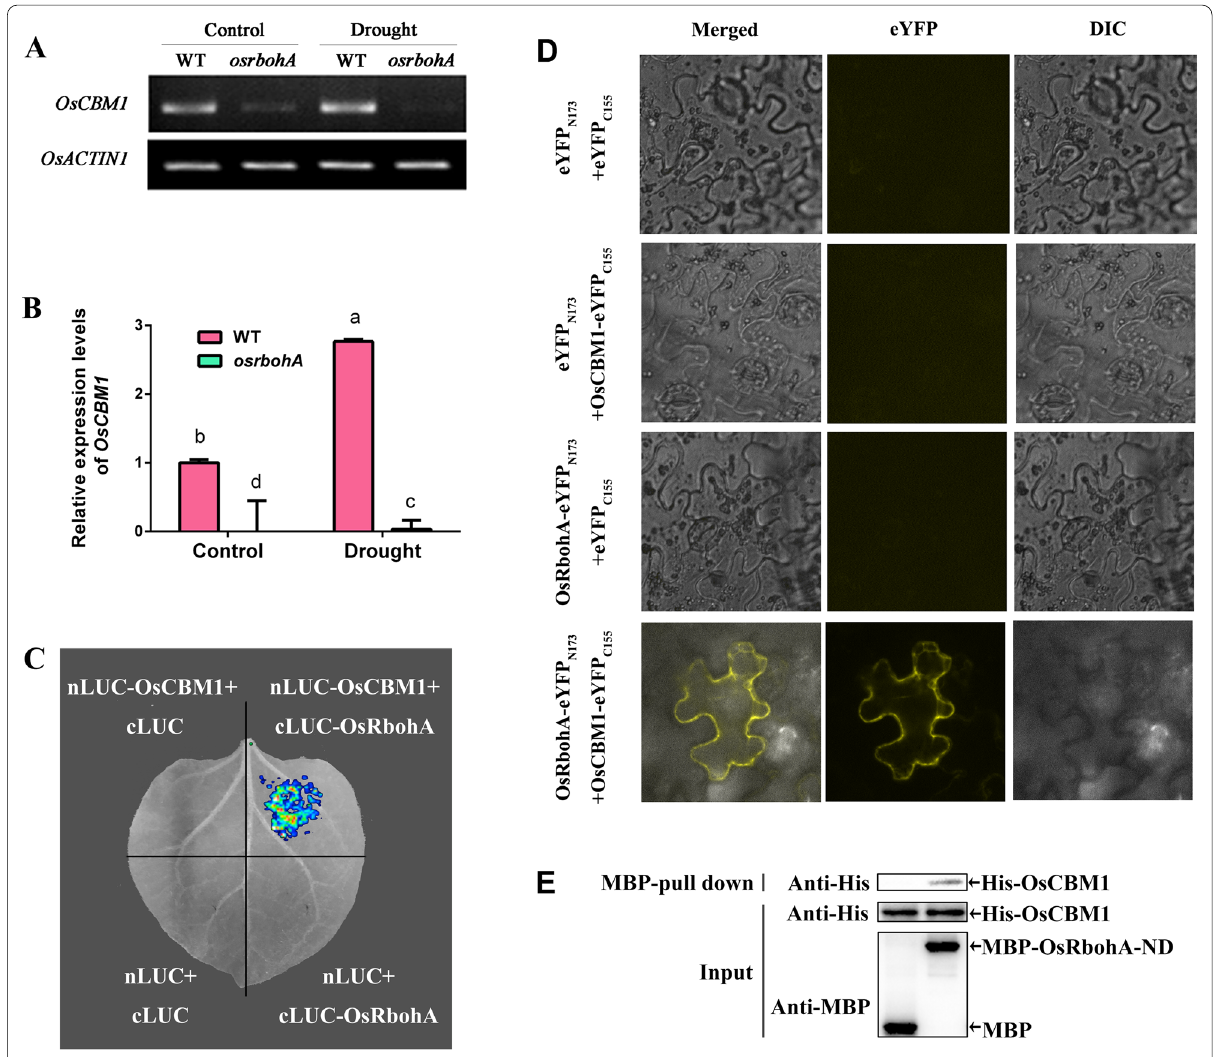
Fig. 4 OsCBM1 interacts with OsRbohA and showed very high coexpressions with OsRbohA. A Expression levels of OsCBM1 in the WT and osrbohA mutant according to a semi‑quantitative RT‑PCR experiment. B Expression levels of OsCBM1 in the WT and osrbohA mutant by qRT‑PCR experiment with OsActin1 as the internal control. The leaves from 6‑week‑old plants under both control and drought were used for the determination. Data are means of three biological replicates (n 12). Bars annotated with different letters represent values that are significantly different ( p 0.05) according = ≤ to a one‑way ANOVA analysis. C Firefly luciferase complementation imaging (LCI) assay, showing the interaction of OsCBM1 with OsRbohA in vivo. D Bimolecular fluorescence complementation (BiFC) assay, showing the interaction of OsCBM1 with OsRbohA in vivo . E MBP‑pull down assay, showing the interaction of OsCBM1 with OsRbohA‑ND (coding 360 amino acid residues at the N‑terminal) in vitro